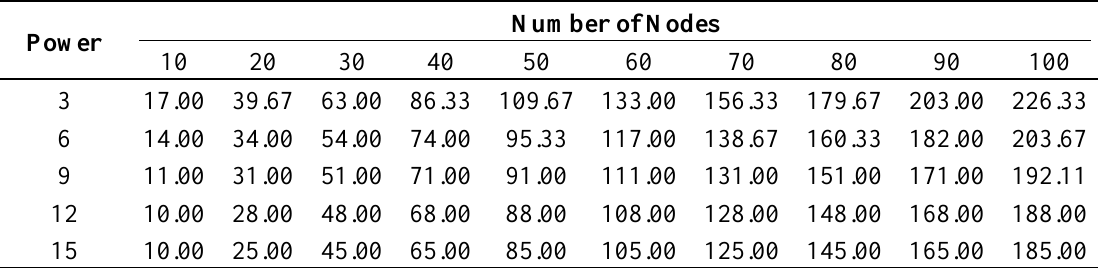
Table 8. Optimal time schedule in a linear topology with fixed power.